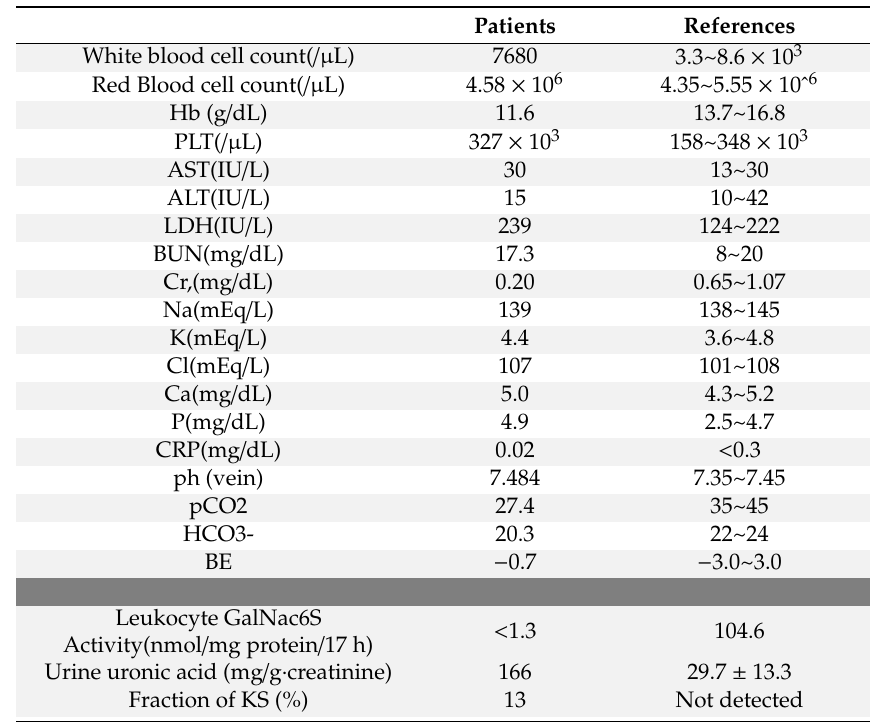
Table 1. The clinical findings from the first visit of a Japanese boy with mucopolysaccharidosis type IVA (MPS